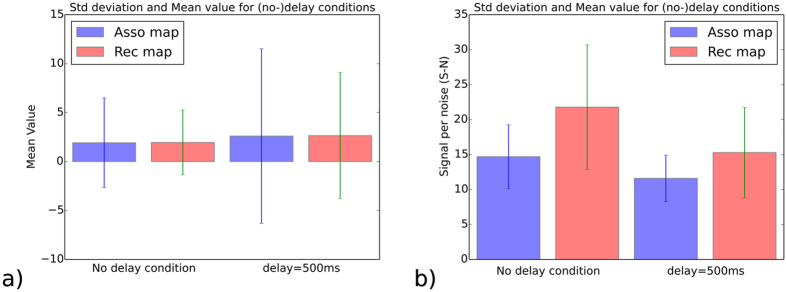
Mean and the standard deviation for the asso. and rec. maps and their confidence level (the signal to the noise), resp. (a) and (b). (a) The graph presents the mean and variance of the neural activity in the non-delay condition (on the left side) and in the situation of a visual delay of 500 ms (on the right side). Visual delays influence the amplitude discrepancy of this measure for the two maps and increase the variance, twice more for the asso map than for the rec map. (b) This measurement quantifies the confidence level of the neural maps to the input stimuli with respect to non-delayed and delayed visual feedback (500 ms). It is computed as the maximum activity minus the local field activity. This measure shows that at the population level it is possible to detect contingency by comparing the activity to a threshold value.